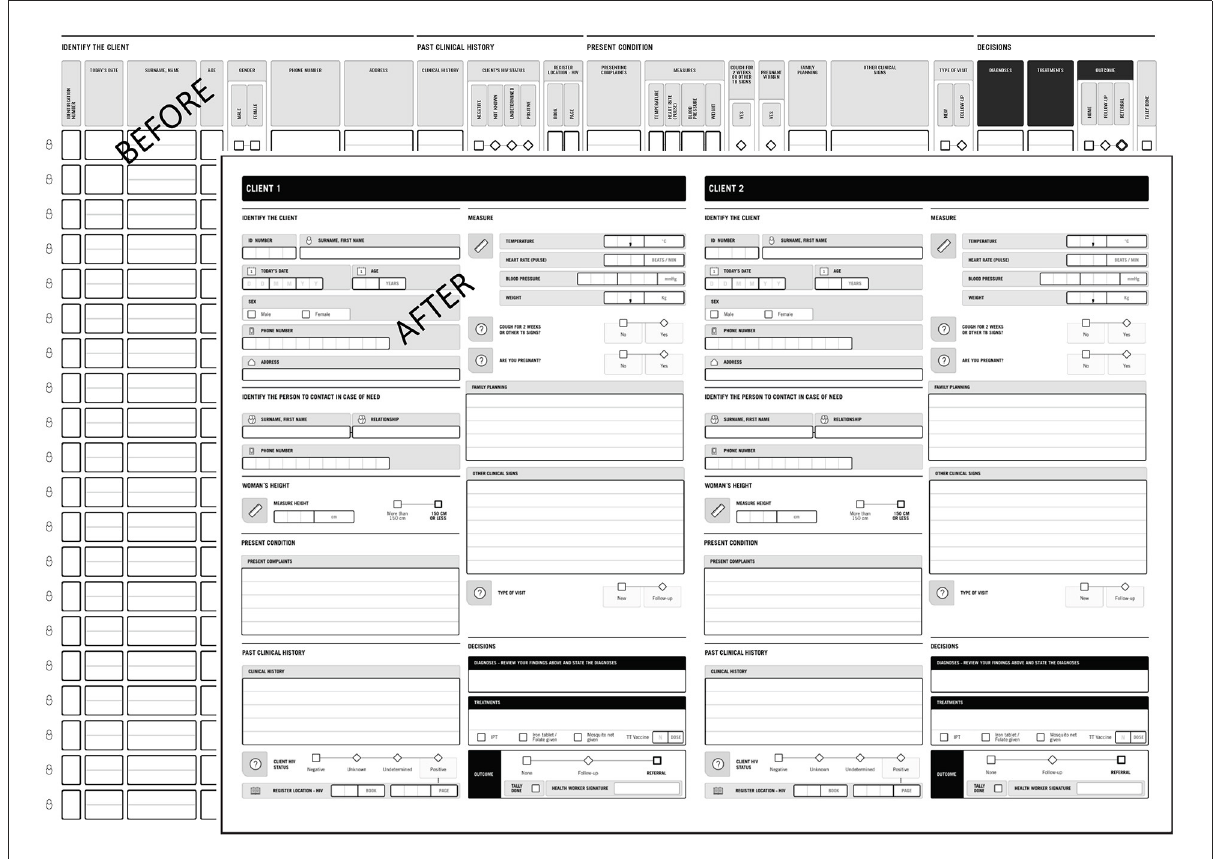
FIGURE2 PHISICC outpatient register, before and after the series of co-design